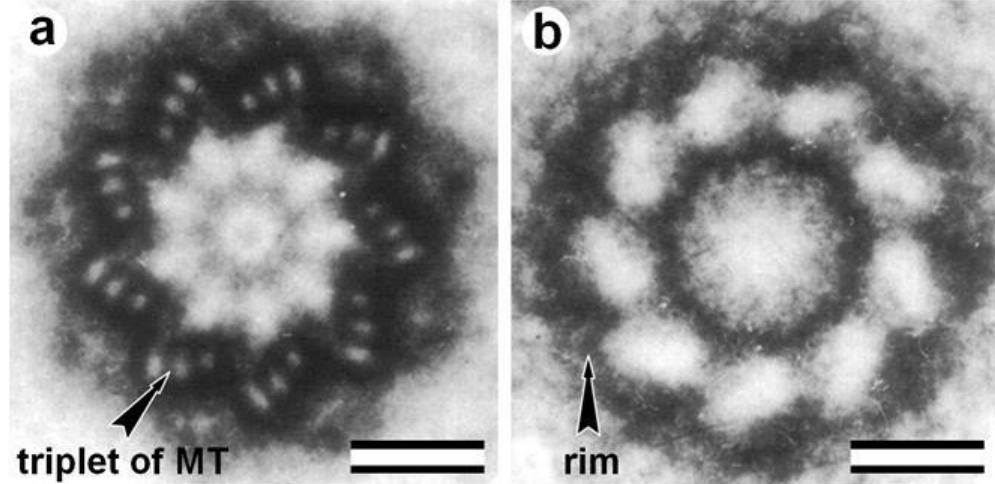
Figure 3. Rotation images of centriole and centriolar rim. Nine photographs with a rotation angle of 40° were superimposed to obtain images: ( a ) centriole; and ( b ) centriolar rim after 1 M KC1 treatment. Scale bar: 100 nm. From [104] with modifications.